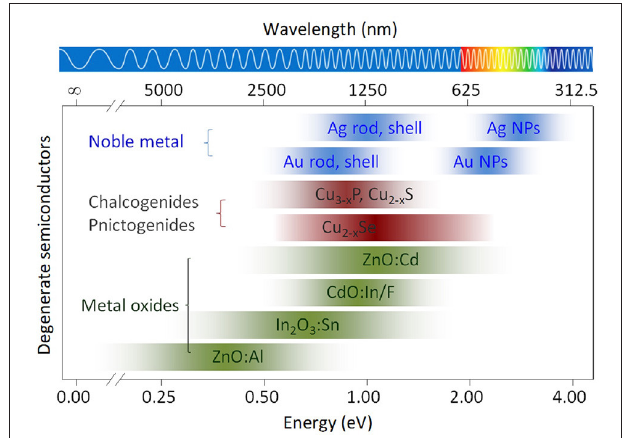
FIGURE 1 | Spectral regions of LSPR for different type of nobel metal, chalcogenide/pnictogenide, and metal oxide based plasmonic materials. Except noble metal based nanostructures, all the plasmonic materials are assumed to have a spherical shape and the change of LSPR is mainly determined by the carrier